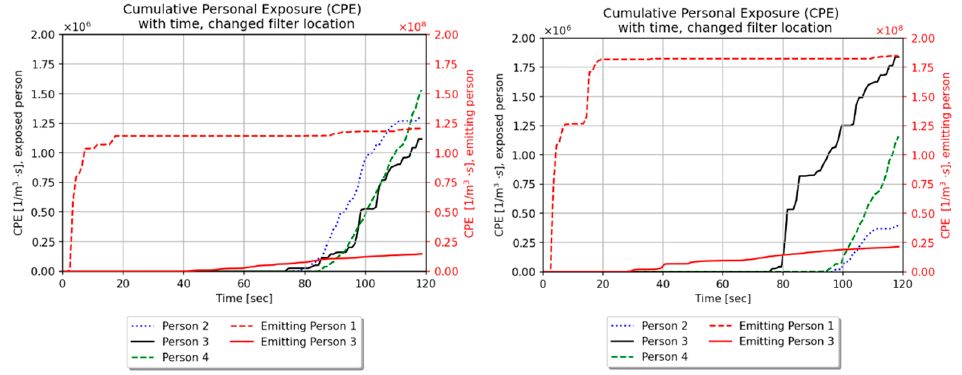
Figure 19. Cumulative particle exposure over time. The equivalent uRANS results are not shown as they show no cummulative exposure for non-coughing occupants.